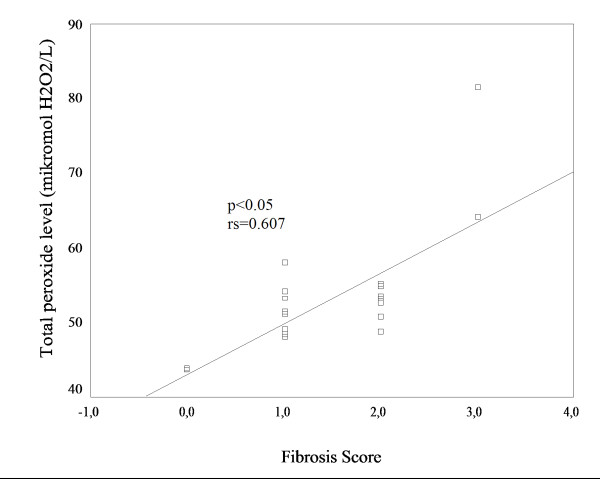
Correlation between serum total peroxide levels and the score of liver fibrosis among nonalcoholic steatohepatitis group.